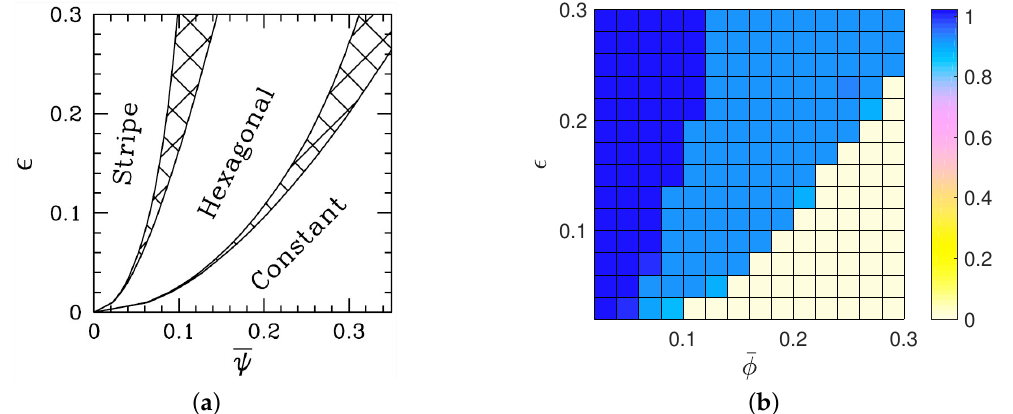
Figure 3. ( a ) Phase diagram (Reprinted with permission from [1]). Here, ¯ ψ denotes the averaged field ( = ¯ φ ). ( b ) Values of Λ ( t ) at t = 2176 with various ¯ φ and (cid:101) .